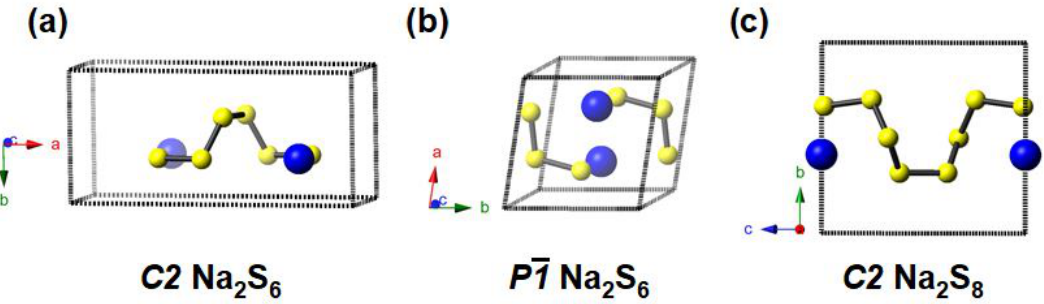
Figure 4. Unit cells of the previously predicted ( a ) C 2-Na 2 S 6 [20], and ( b ) P 1-Na 2 S 6 polymorphs. ( c ) Unit cell of the newly predicted C 2-Na 2 S 8 phase. Sodium atoms are colored blue, and sulfur atoms are